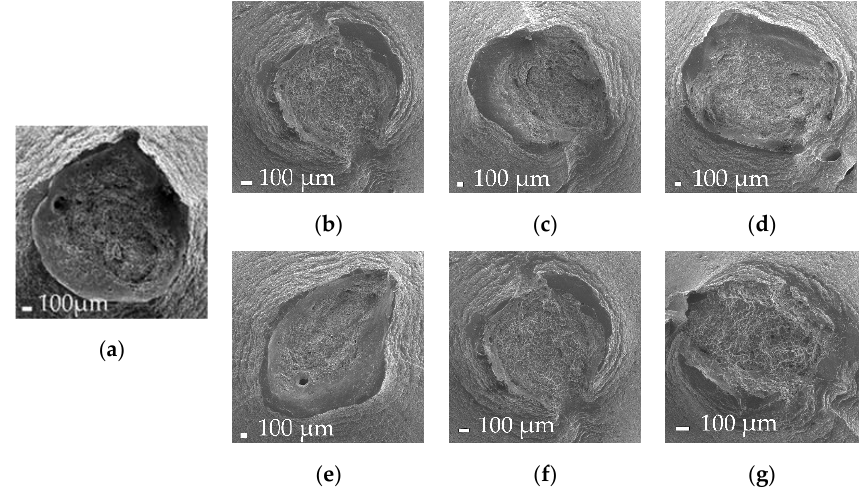
Figure 6. Aspect of breakage zone ( x 30) in representative samples: ( a ) Ø 9.43 mm. initial rod wire, ( b ) 1 rst reduction Ø 9.43–8.92 mm, ( c ) 3 rd reduction Ø 7.92–6.99 mm, ( d ) 5 th reduction Ø 6.20–5.47 mm, ( e ) 7 th reduction Ø 4.85–4.28 mm, ( f ) 9 th reduction Ø 3.81–3.36 mm and ( g ) 10 th reduction Ø 3.36–2.98 mm.